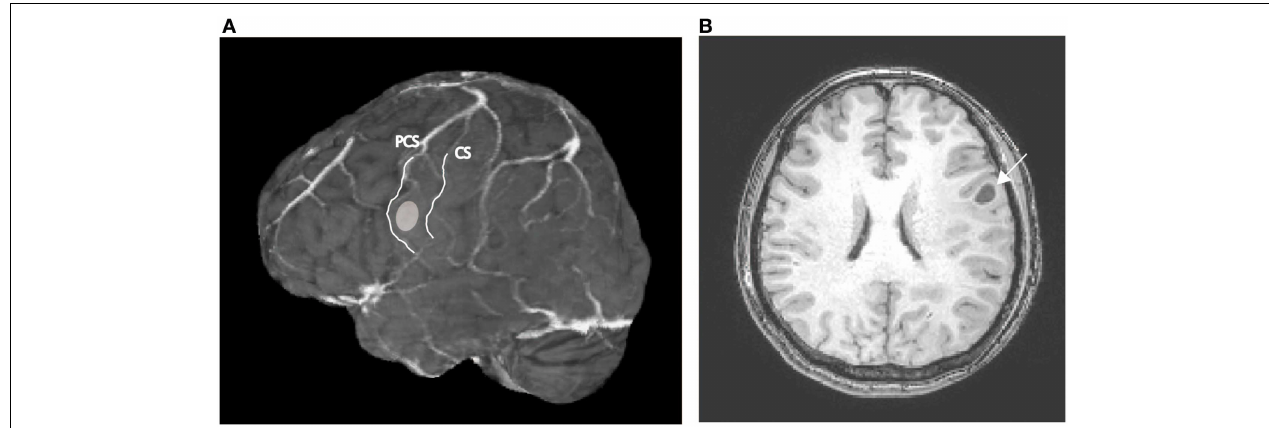
FIGURE 1 | (A) Preoperative MR image of the patient’s brain; the ellipsoid indicates the location of the tumor. CS, central sulcus; PCS, precentral sulcus. (B) Axial section of the preoperative T1-weighted MRI; the arrow indicates the tumor in the left precentral gyrus.